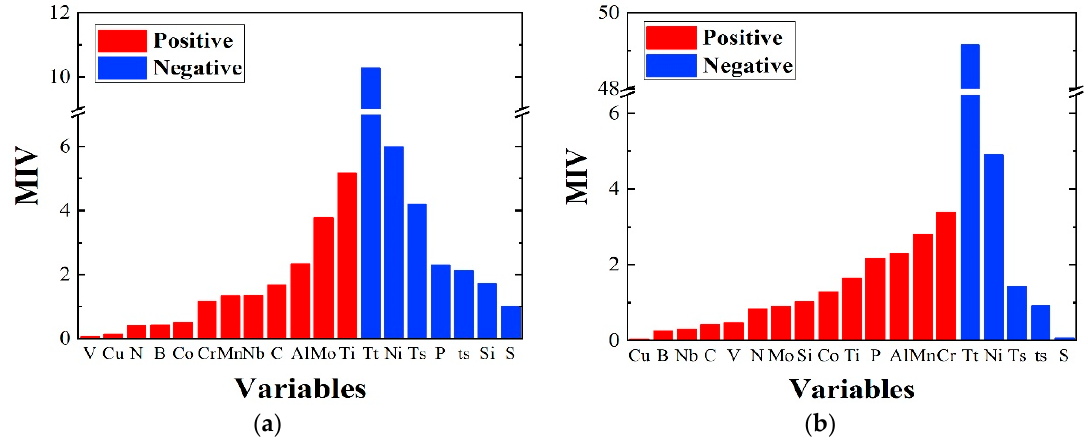
Figure 6. The absolute values of mean impact value (MIV) of each variable on two tensile properties: ( a ) YS and ( b ) UTS. The red and blue columns represent the positive and negative correlation, respectively (The higher the MIV value, the greater the effect on the corresponding tensile properties).